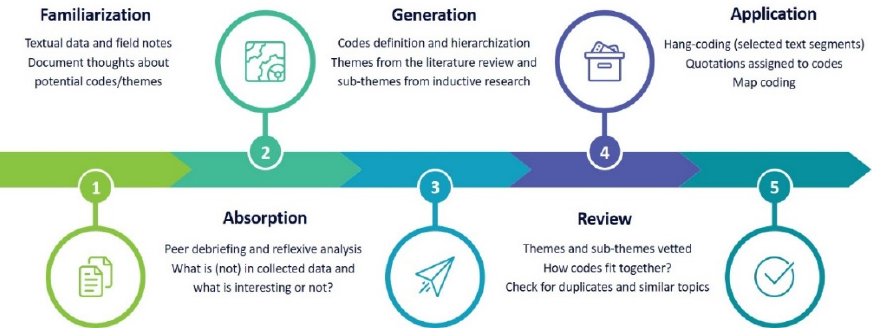
Figure 2. Thematic analysis process. Source: own elaboration.